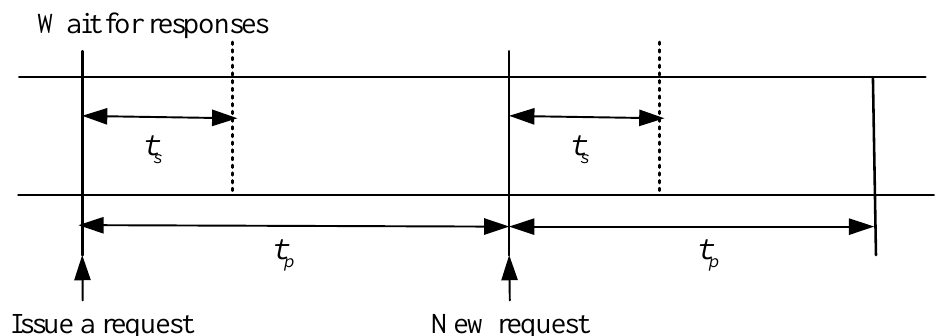
Figure 2. A time-slotted structure for broadcasting periodical crowdsensing tasks and waiting for the crowd workers’ responses.